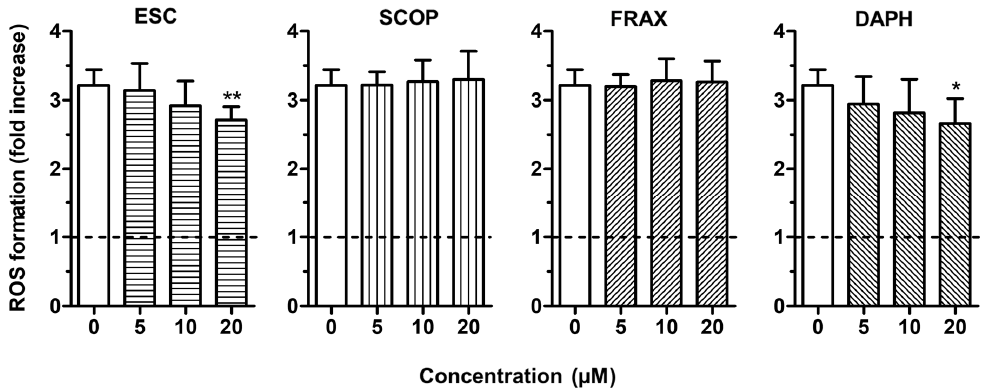
Figure 3. ESC and DAPH, but not SCOP and FRAX, prevent t -BuOOH—induced ROS formation in SH-SY5Y cells. Cells were treated for 24 h with various concentrations of the studied coumarins (5–20 µ M) and then with t -BuOOH (200 µ M) for 30 min. At the end of treatment, ROS formation was determined using the fluorescent probe DCFH-DA. Data are expressed as fold increases of ROS formation induced by t -BuOOH and reported as mean ± SD of four independent experiments (* p < 0.05 and ** p < 0.01 vs. cells treated with t -BuOOH at one-way ANOVA with Dunnett post-hoc test).